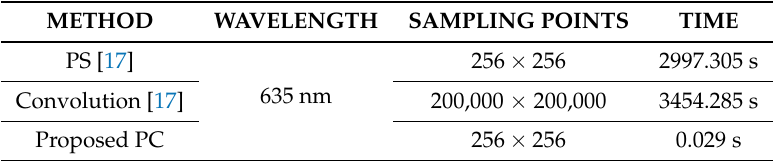
Table 3. Comparison of sampling points and calculation time required using different calculation method in visible